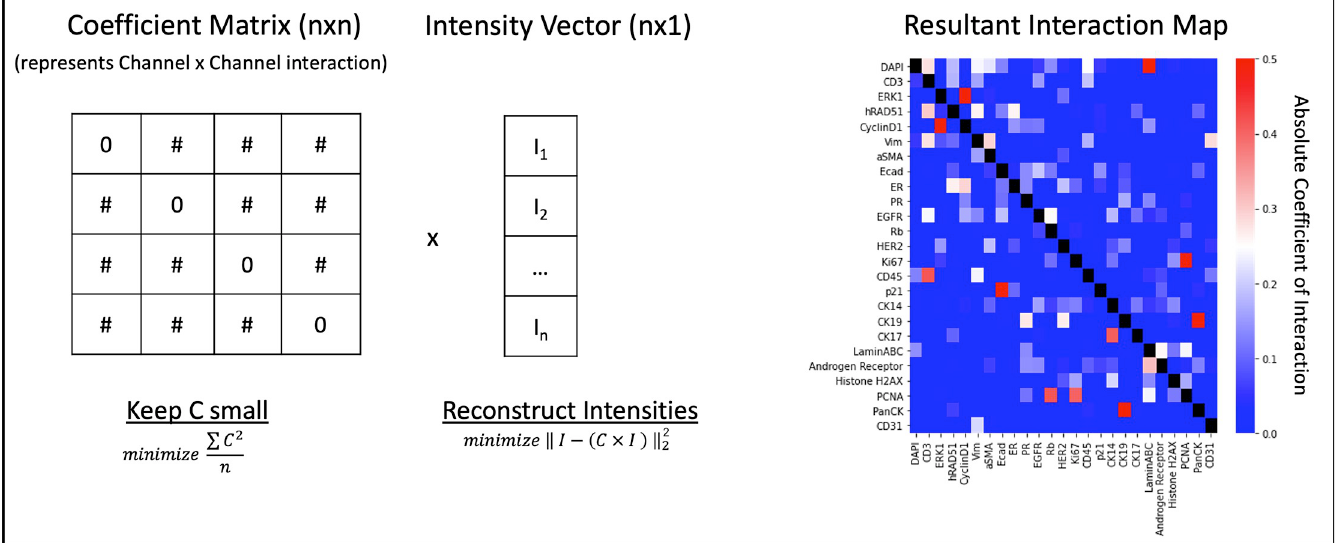
Fig 8. Diagram demonstrating the trained coefficient matrix and the resultant interaction map used to select a reduced panel. A model is trained to optimize the Coefficient Matrix ( C ) with a forced zero diagonal, such that it is sparse and when multiplied by the intensity vector of each single cell ( I ) it can reconstruct I as closely as possible. The resultant interaction map is the trained weights of C , showing the interactions of each marker necessary to adequately reconstruct each other marker in an image. Some makers are capable of being reconstructed from only one other marker, other markers require a more complex combination, and some are not well predicted by